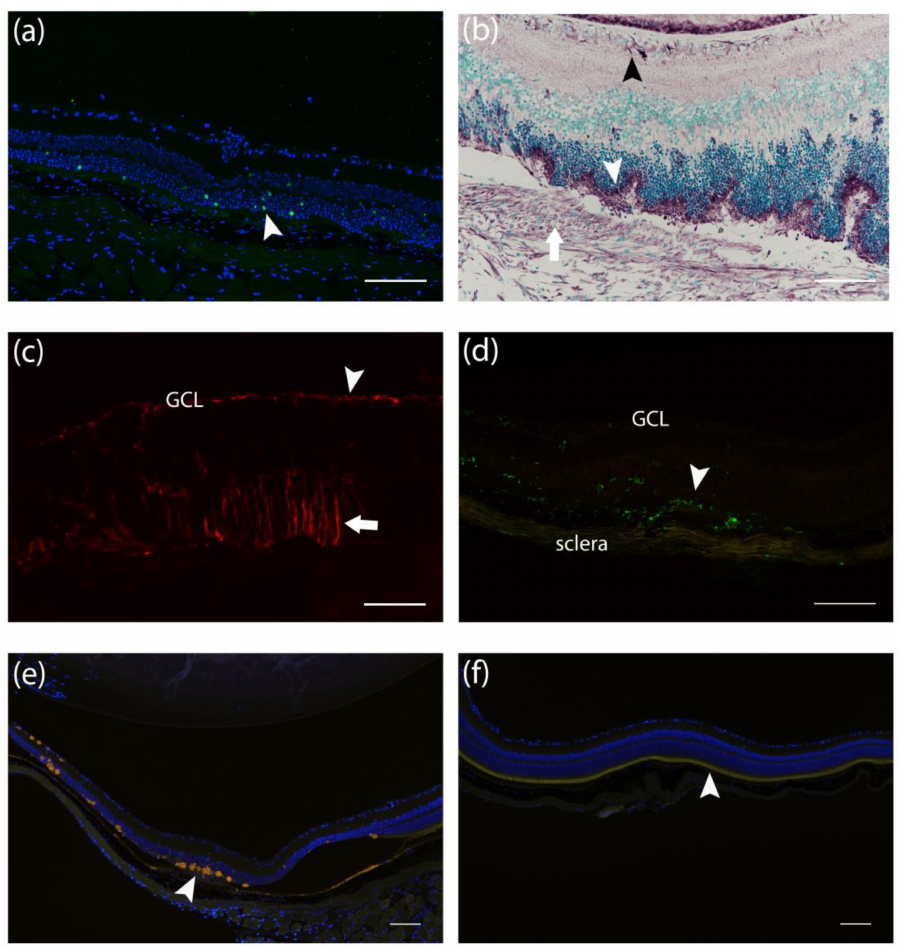
Figure 5. Morphologic changes and transgene expression in the Cre and LacZ injected eyes. ( a ) β -gal expression (arrowhead) after LacZ injection was seen two weeks after gene transfer but not at later time points. ( b ) VEGF-A expression (violet) in ganglion cell layer (black arrowhead), photoreceptors (arrowhead), and neovascular membrane (arrow) in the eye of Cre -injected mouse. ( c ) Glial fibrillary acidic protein (GFAP) immunoreactivity was observed in the nerve fiber layer (arrowhead) and Müller cells (arrow) in the outer retina post- Cre injection. ( d ) In the Cre group, F4/80 positive macrophages were seen in the retina and subretinal layers. ( e , f ) Retinal autofluorescence (yellow) with DAPI nuclear counterstain (blue). In Cre -injected retina (e), drusen-like lipofuscin deposits (arrowhead) and the loss of photoreceptors were seen. Intact photoreceptor layer (f, arrowhead) was observed in LacZ -injected eyes. Scale bar is 100 µ m. GCL: Ganglion cell